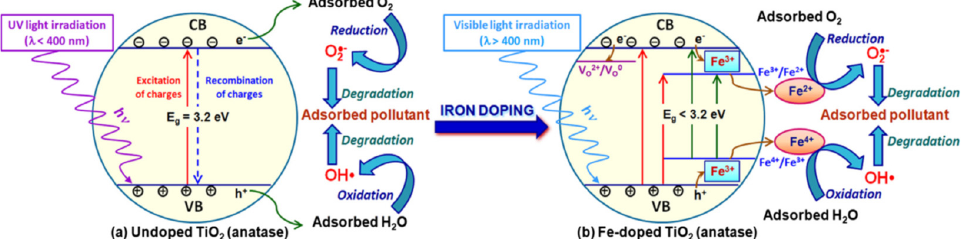
Figure 5. Schematic representation of the electronic band structure of ( a ) undoped anatase TiO 2 and ( b ) Fe-doped anatase TiO 2 . Reprinted/adapted with permission from Ref. [131]. 2018, Elsevier.